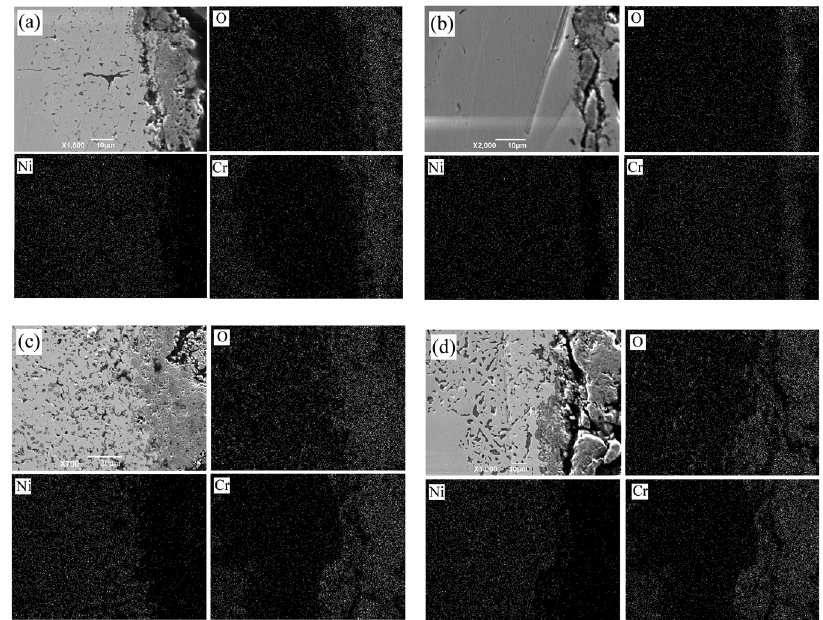
Figure 7: Cross-section views and elemental distribution maps of the corrosion products formed in (a) NaCl, (b) KCl, (c) MgCl 2 and (d) CaCl 2 molten salts after 20 h at